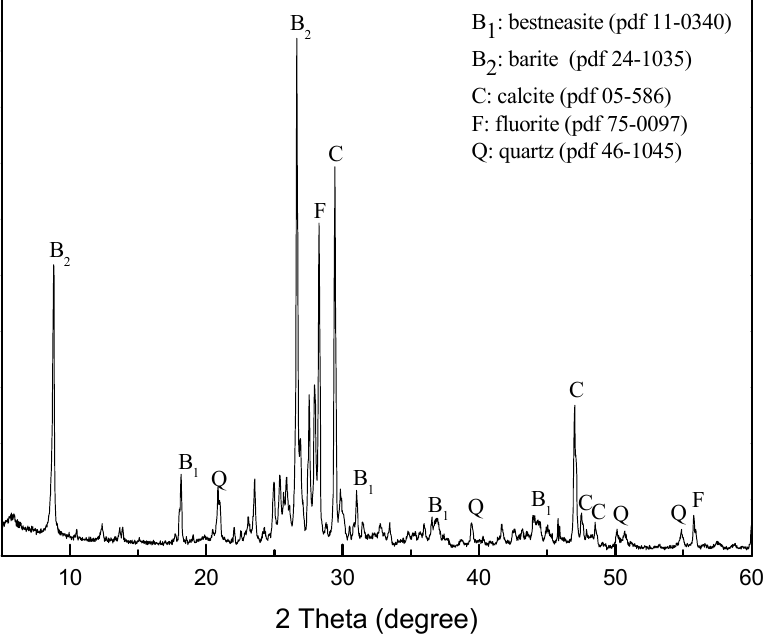
Figure 1. X-ray diffraction (XRD) pattern of the raw ore collected from Mianning deposit in Sichuan province, China.